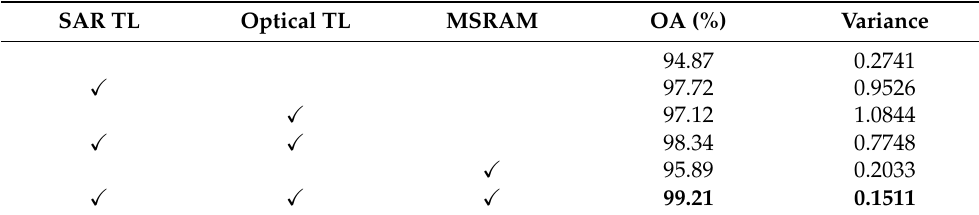
Table 4. Comparison of different transfer learning methods. SAR TL